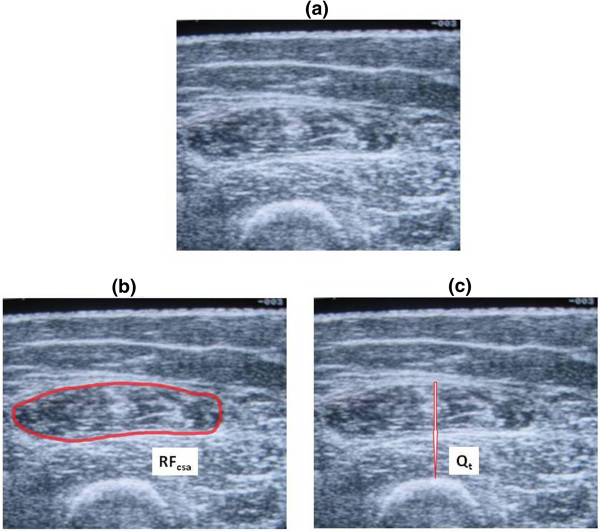
Ultrasound image of the quadriceps. Sample scan of a study participant showing (a) Image at mid-thigh region, (b) RFcsa, and (c) Qt.